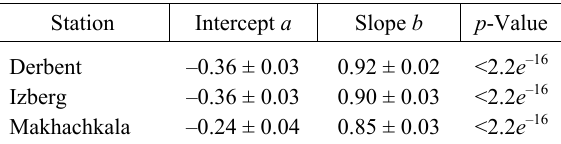
Table 2. Parameters of the linear regression line between monthly averaged values of ,sat S in situ H H  and ,sat S H (Fig. 5, right) for the Derbent, Izberg and Makhachkala observation sites Station Intercept a Slope b p -Value